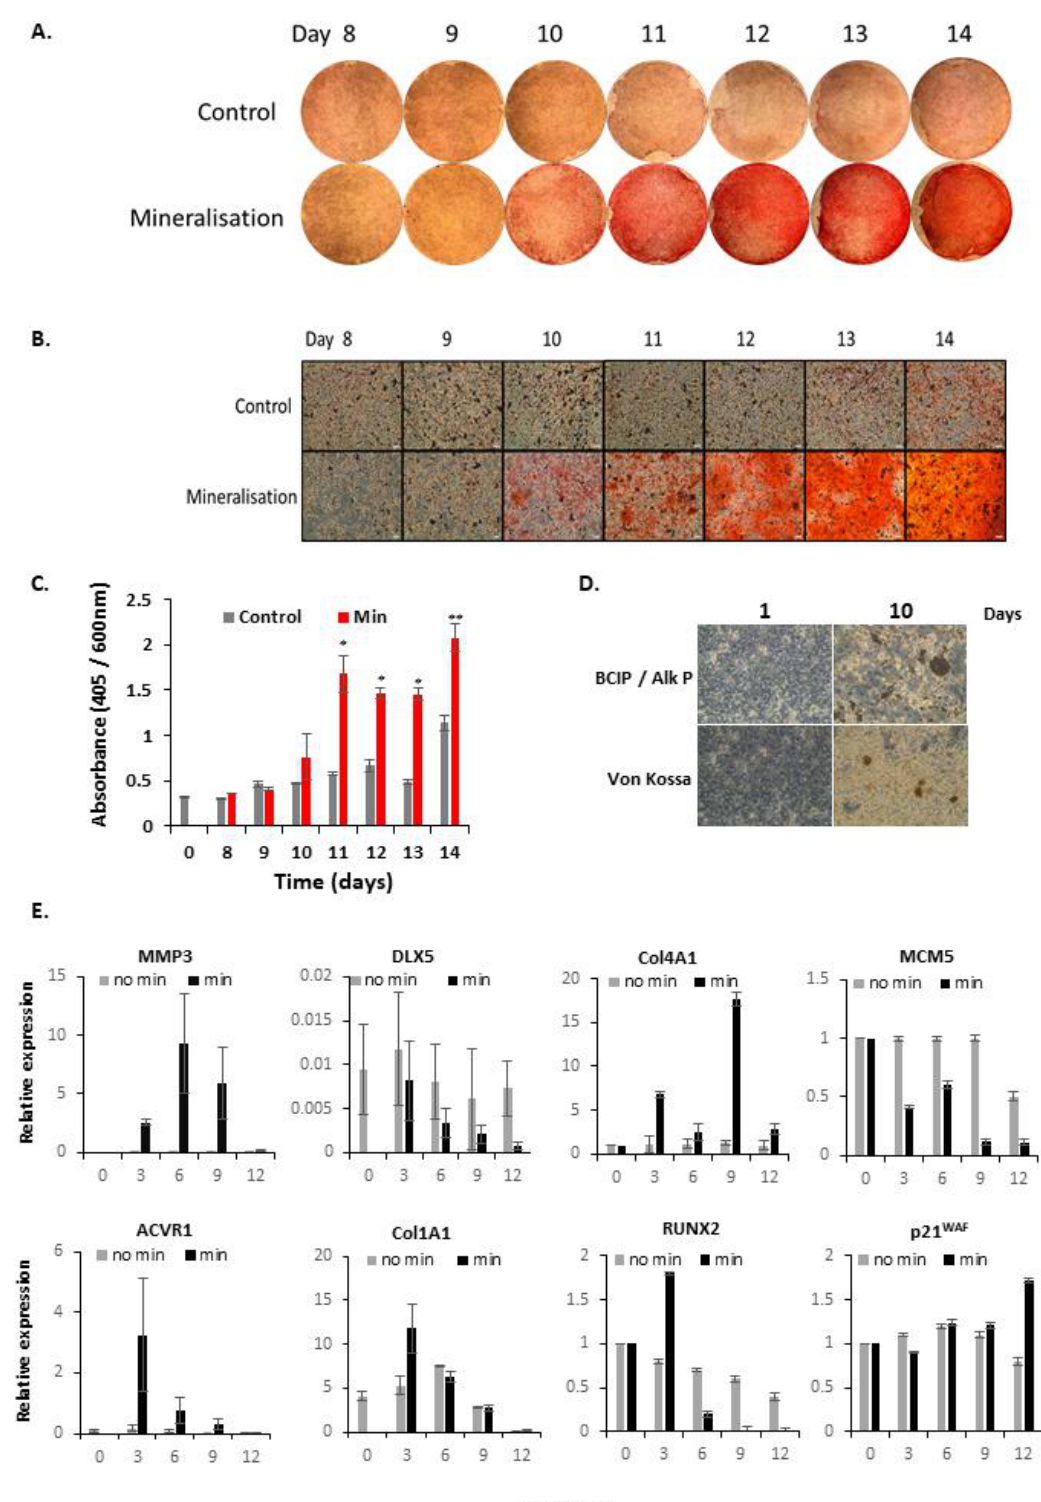
Figure 1. Characterisation of Mineralising 7F2 Osteoblasts. 7F2 bone marrow osteoblasts were stimulated to mineralise in osteogenic media containing 5 mM β -glycerophosphate, 0.1 g/L ascorbic acid, 10 − 8 mol/L menadione and 10 − 7 mol/L vitamin D3. A , Whole well images of 7F2 cells grown